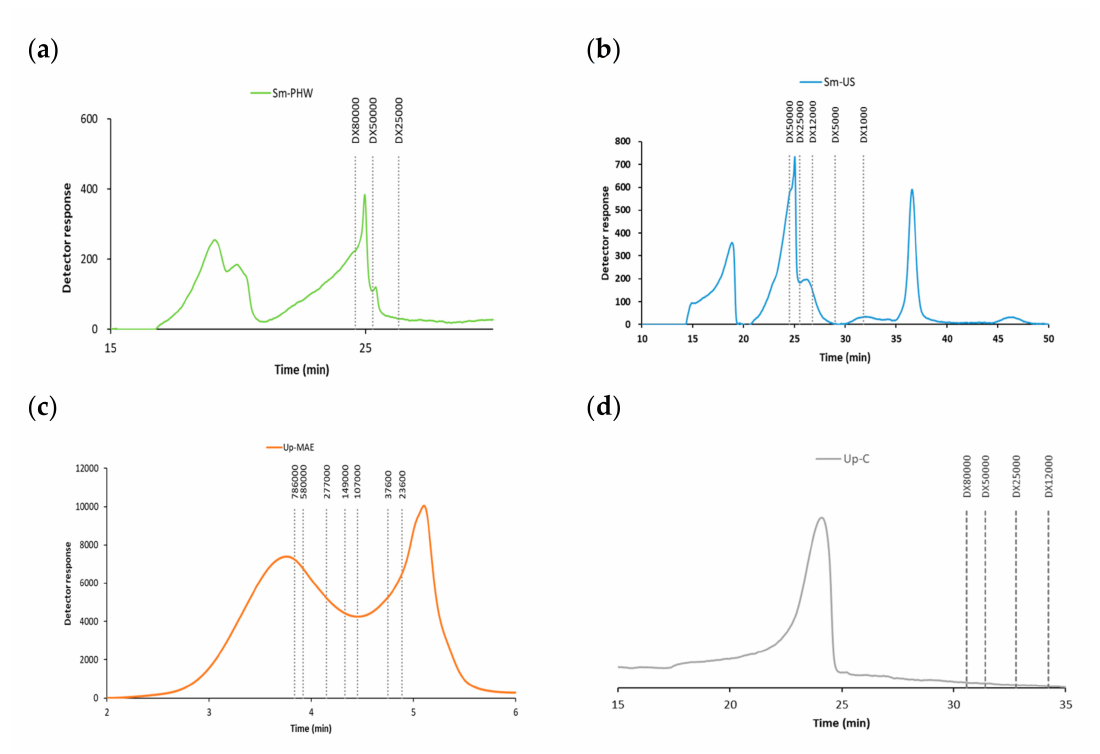
Figure 2. Detailed molar mass distribution profiles for crude fucoidan obtained from Sargassum muticum (Sm) using ( a ) pressurized hot-water extraction (Sm-PHW) and ( b ) ultrasound-assisted extraction (Sm-US), ( c ) the profile of the crude fucoidan obtained from Undaria pinnatifida (Up-MAE), and ( d ) the profile of the commercial fucoidan from Undaria pinnatifida using microwave-assisted extraction. Adapted from [31,38–40].